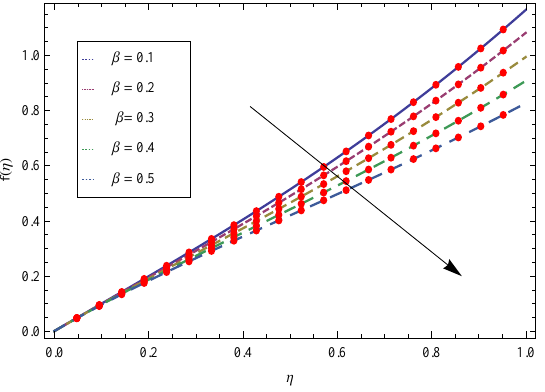
Figure 22. The effect of Nt on φ ( η ) , for h = − 0.9, λ = 0.5, S = 0.7,kr = 0.5,Pr = 0.5,Ec = 0.5, Nb = 0.7, β = 1 and Sc = 0.5.